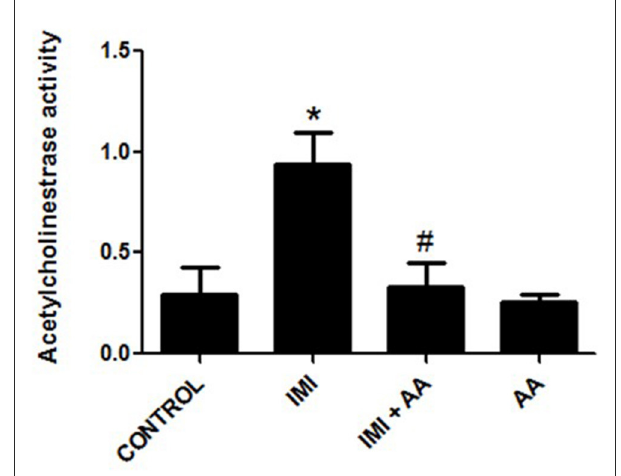
FIGURE3 The acetylcholinesterase activity in all studied groups. AchE activity was measured in controls, IMI, IMI + Ascorbic acid, Ascorbic acid treated animals. Data represent mean ± SEM. n = 6 for each group. * Represents significant values when compared to controls at p < 0.05, # represents significant values when compared to IMI-treated animals at p < 0.05 (IMI,